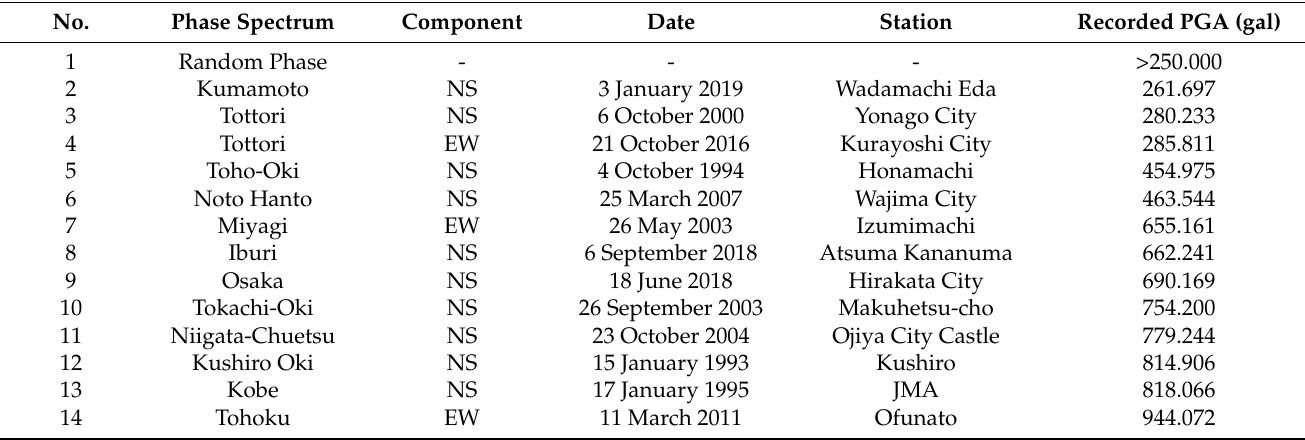
Table 5. List of the earthquake used for a phase spectrum to scale the probable earthquake